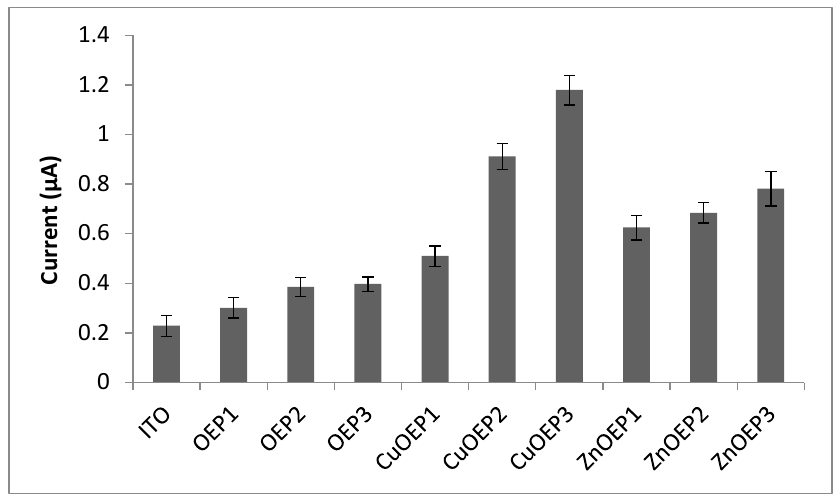
Figure 5. Analytical signal (n = 3) obtained on phenobarbital 0.001 mol · L − 1 in LiClO 4 0.05 mol · L − 1 by cyclic voltammetry with different modified electrodes. Potential range: 0.0 V–1.2 V (vs. Ag/AgCl), scan rate 0.1 V s − 1 . Electropolymerization conditions: (1) − 1.0 to 1.7 V; (2) 0.0 to 1.6 V; and (3) 0.0 to 2.2 V.